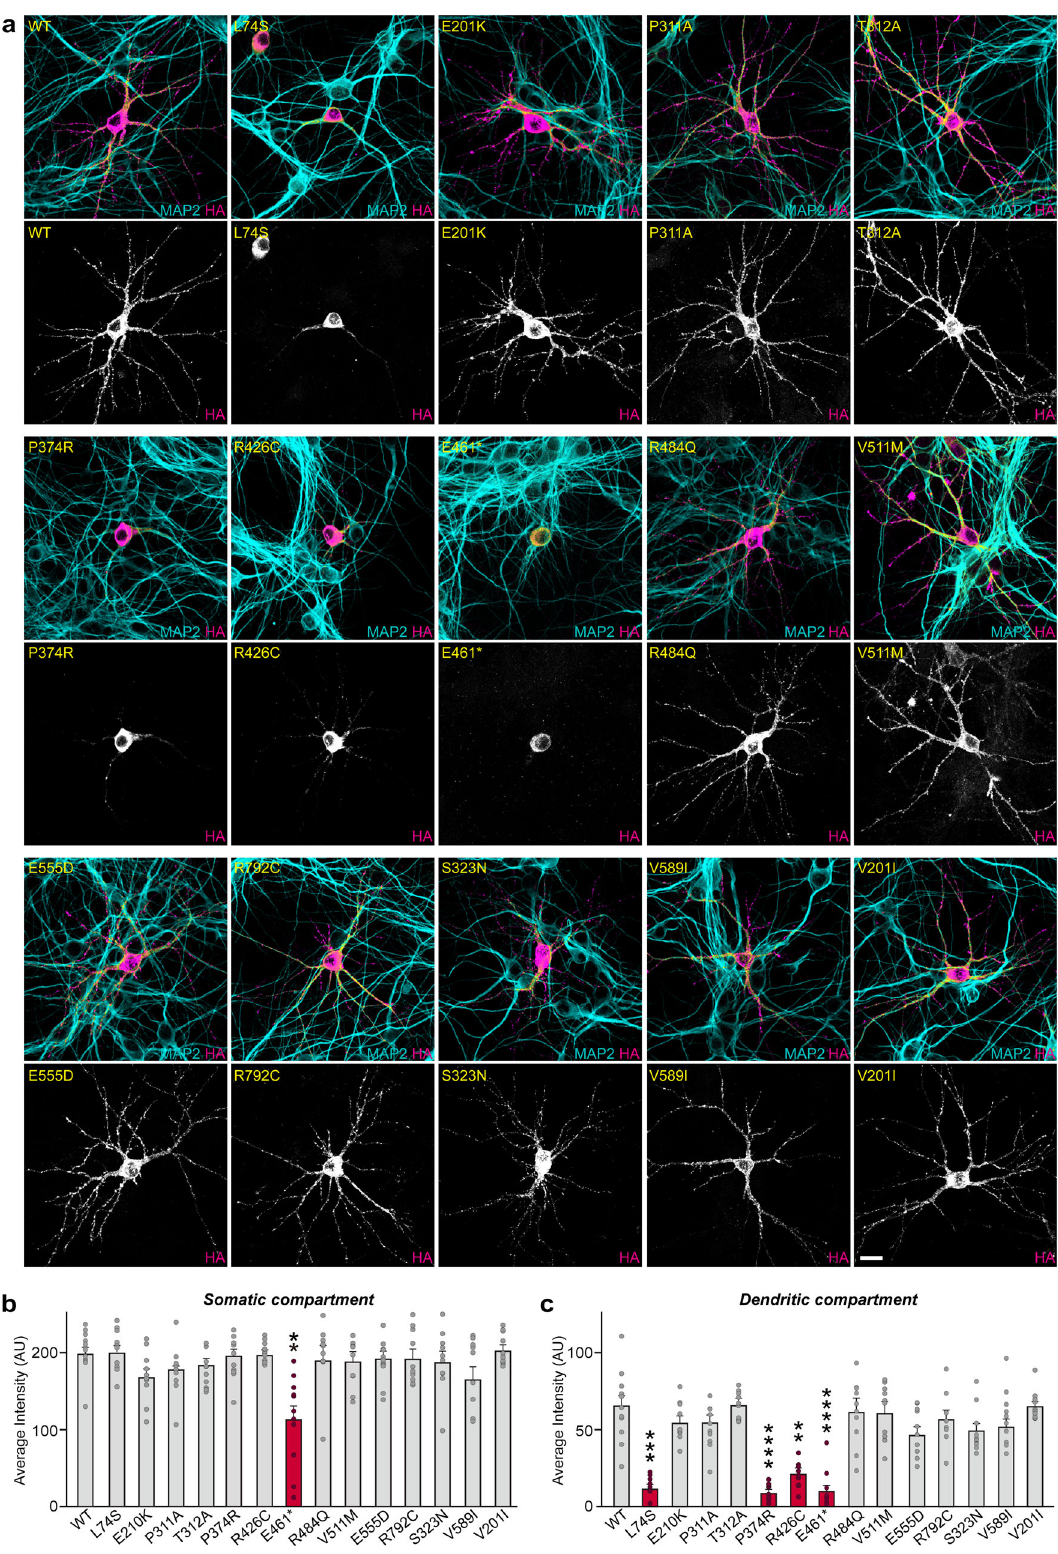
signi fi cantly decreased TrkB-FL levels, but markedly increased TrkB-T levels (Fig. 7a, b), suggesting that SLITRK2 might reduce forward traf fi cking of TrkB and/or trigger the truncation of TrkB- FL. Strikingly, T312A abolished the ability of SLITRK2 WT to decrease TrkB-FL levels (Fig. 7a, b). In addition, the effects of L74S, P374R, R426C, or E461 * were similar to those of